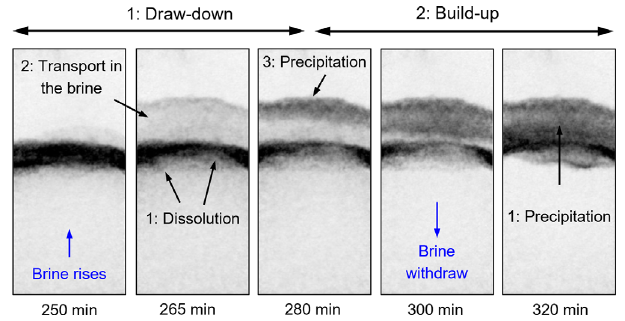
Fig. 13. 2D X-ray projections during (1) a gas draw-down (see cycle 1 in Fig. 12), and (2) a gas build-up (see cycle 2 in Fig. 12). Gas is injected from the top. Darker shades suggest salt bank position.